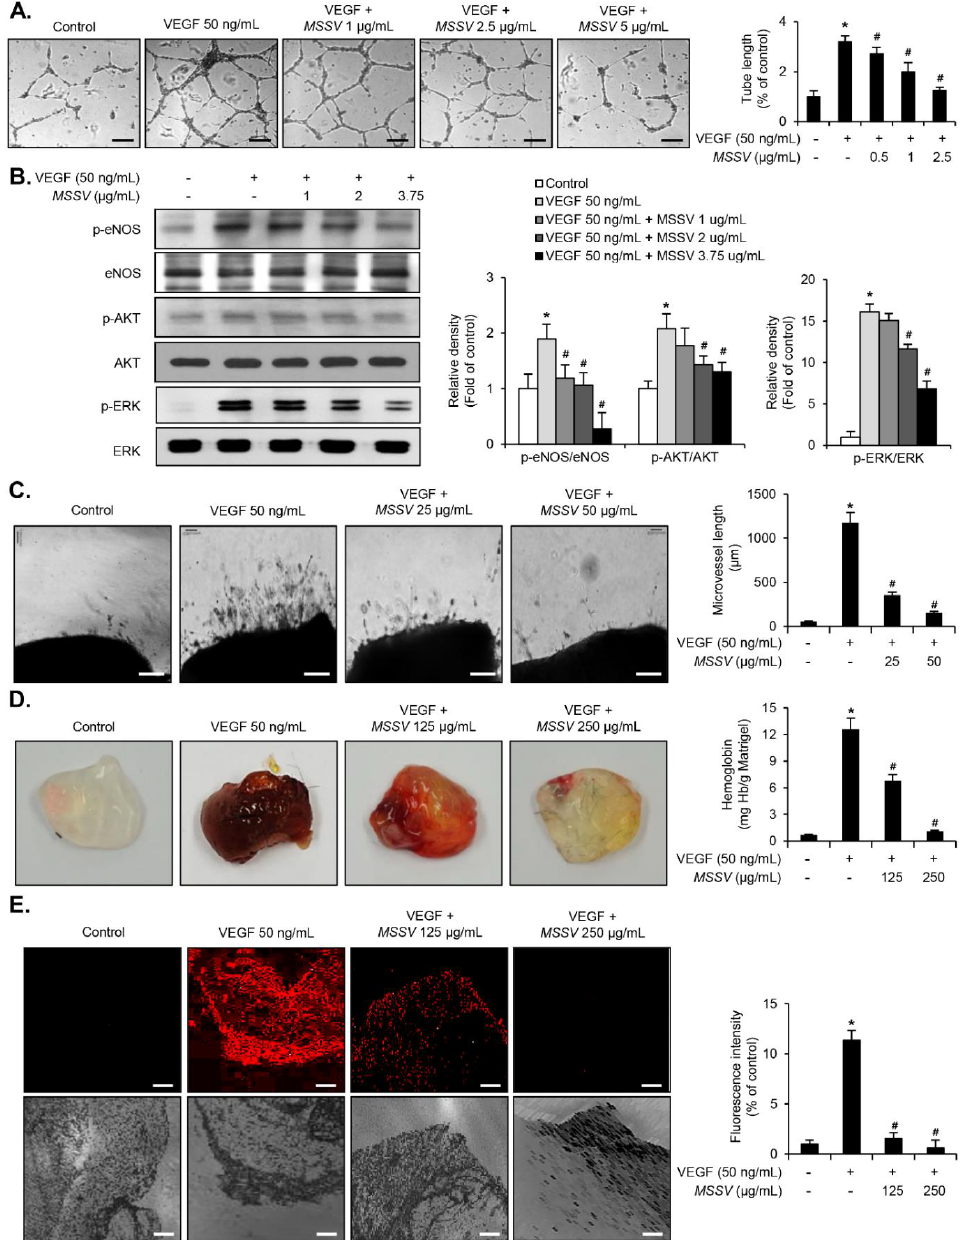
Figure 7. Effect of MSSV in VEGF-induced angiogenic responses in vitro, ex vivo, and in vivo. ( A ) HUVECs were treated with VEGF (50 ng/mL) for 1 h, followed by the indicated concentrations of MSSV for 24 h. The HUVEC tube formation assay was accomplished using Matrigel (scale bars = 200 µ m). ( B ) Immunoblot analysis for antibodies specific for phospho- ERK1/2, ERK1/2, phospho-AKT, AKT, phospho-eNOS, and eNOS. ( C ) Blood neo-vessel sprouting in the mouse aorta after MSSV treatment in the presence of VEGF (50 ng/mL) was evaluated using aortic ring assay (scale bars = 200 µ m). Bar graphs show the relative fold changes in the number of emerging neo-vessel associated with MSSV + VEGF treatment in comparison with that associated with VEGF treatment alone. ( D ) Blood vessel formation was performed using a Matrigel plug in an in vivo experiment. Blood vessel formation was assessed by measuring hemoglobin content in Matrigel. Bar graphs show the relative fold changes in the hemoglobin content associated with MSSV + VEGF treatment in comparison with that associated with VEGF treatment alone. ( E ) Analysis of vessel formation in Matrigel plug was performed by CD31 immunostaining (scale bars = 100 µ m). Bar graphs show the relative fold changes in the density of CD31-positive vessels during MSSV + VEGF treatment as compared with that during VEGF treatment alone. All data are represented as the mean ± SE from three independent experiments. * p < 0.05 compared with control and # p < 0.05 compared with VEGF treatment. Uncropped Western Blot Images in Figure